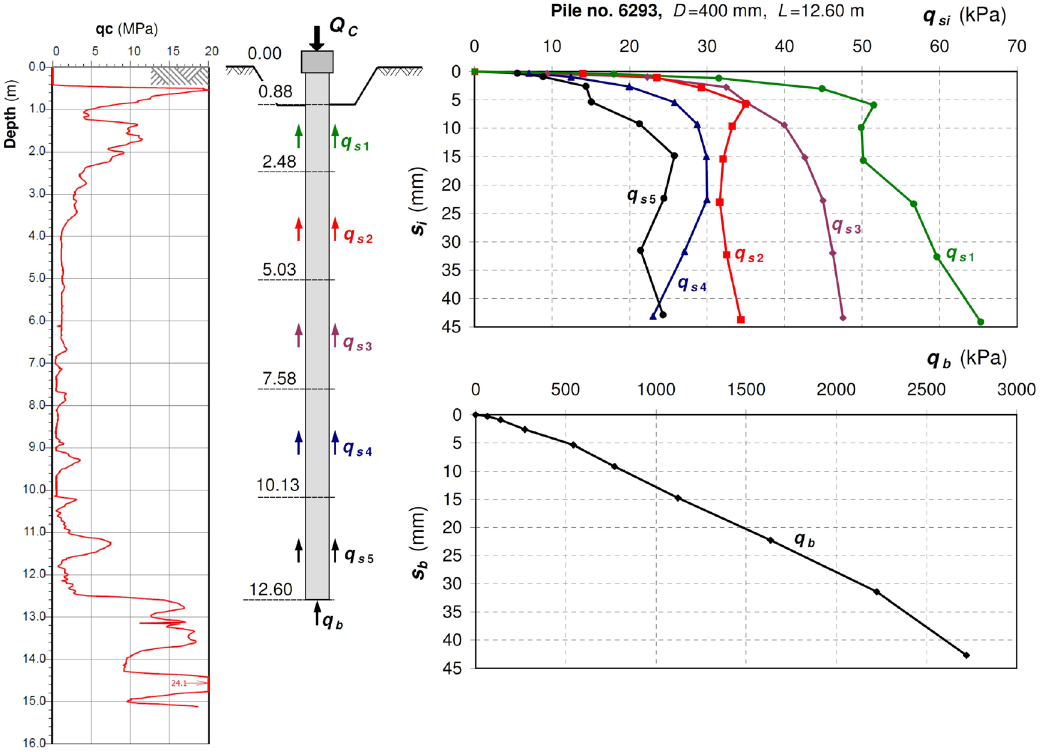
and q unit soil resistances around the pile, based on the data from Figs 2 and 6, without taking s b